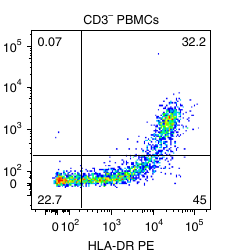
Fig. 3 Antigen presentation by ex vivo PB ILCs. a Experimental work fl ow to evaluate the antigen-presentation capacity of PB ILC subsets to autologous CMV-pp65-speci fi c CD4 + memory T cells. b Representative fl ow cytometric dot plots of IFN- γ and TNF- α production by expanded CMV-pp65-speci fi c CD4 + memory T cells after co-culture with autologous CMV-pp65 protein-loaded cell subsets, CD3 − cells left unloaded, or in response to CMV-pp65 peptide stimulation. c Summarized data of frequencies of responsive (IFN- γ + , TNF- α + , and/or CD40L + ) CMV-pp65-speci fi c CD4 + memory T cells after co-culture with autologous CMV-pp65 protein-loaded cell subsets or CMV-pp65 peptide stimulation. N (donors) = 6. Due to limited cell numbers, we could not generate data for all conditions for every donor; source data are provided as a source data fi le. Bars and error bars indicate mean and SEM. d Representative plot of HLA-DR and CD40 expression on CD3 − cells present in the autologous CMV-pp65-speci fi c co-culture